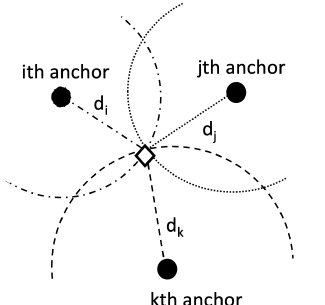
Figure 11. Geometrical model for range-based multilateration. To resolve the position of the target (represented by the rhomboid), one must find where the circles intercept.